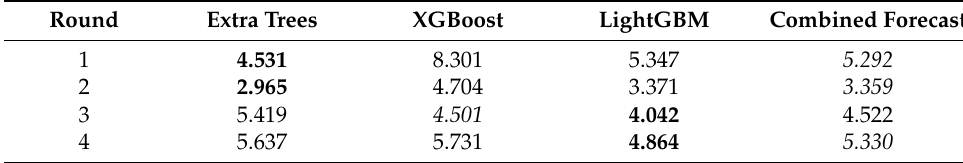
Table 5. MAPE (%) values on the submission period for individual models and the combined result. Lowest error rate in bold , second lowest in italic .